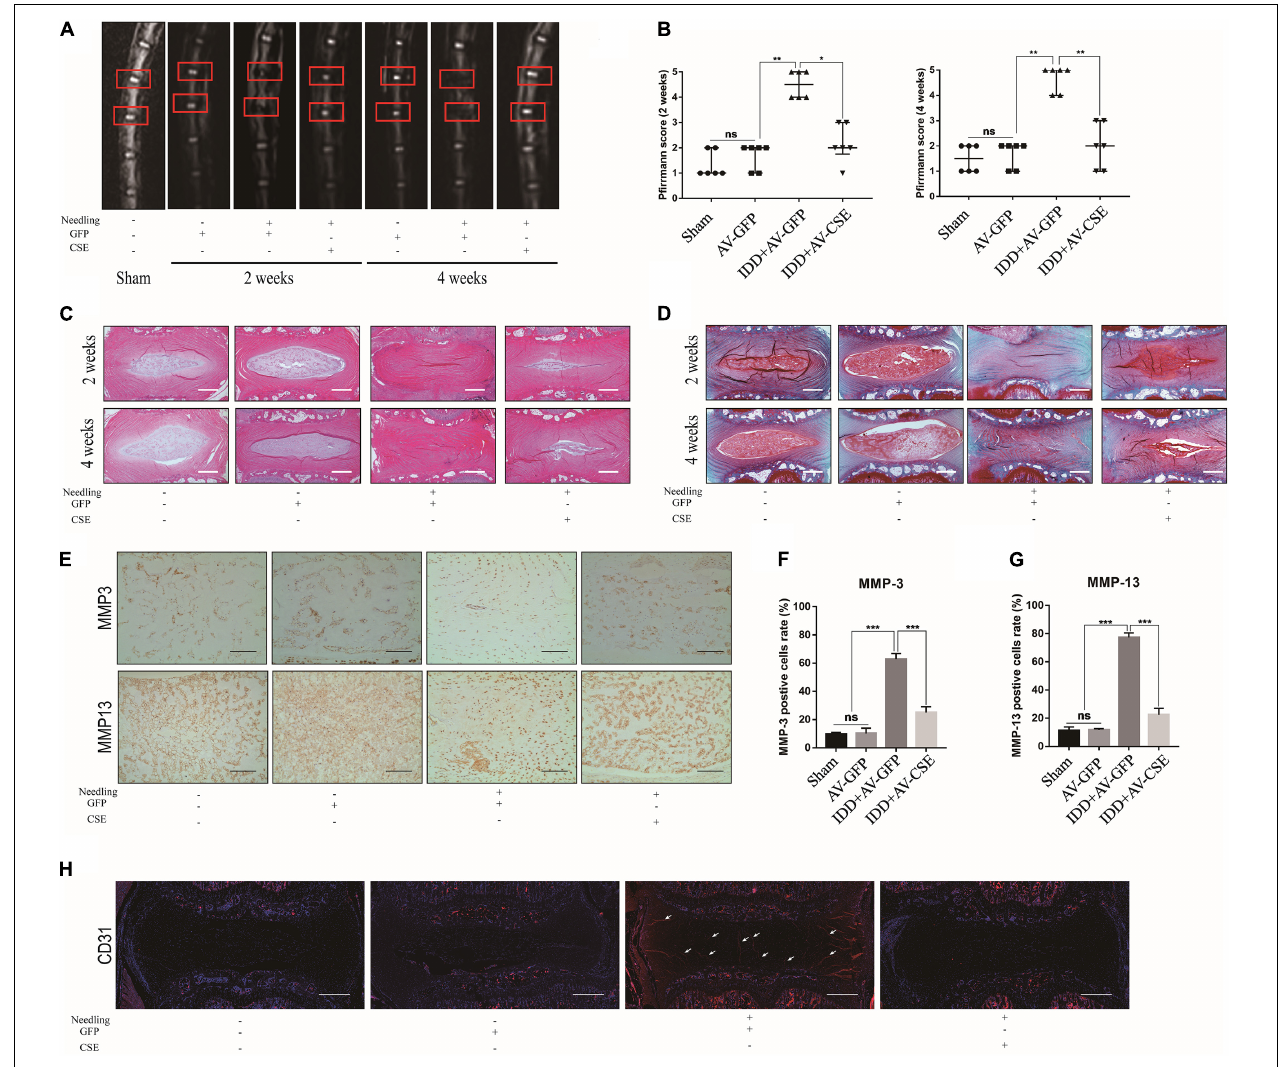
FIGURE 7 | Effects of AV-CSE on rat IDD model. (A) T2-weighted MRI images of rat tail at 2 and 4 weeks post-surgery (red boxes: needle-puncture disc locations). (B) Pfirrmann MRI scores ( n = 6). (C) Representative H&E and (D) Safranin O/Fast Green staining images. (E) IHC images of MMP-3 and MMP-13 and (F,G) quantification. (H) CD31 IF images. Black scale bar: 100 µ m. White scale bar: 500 µ